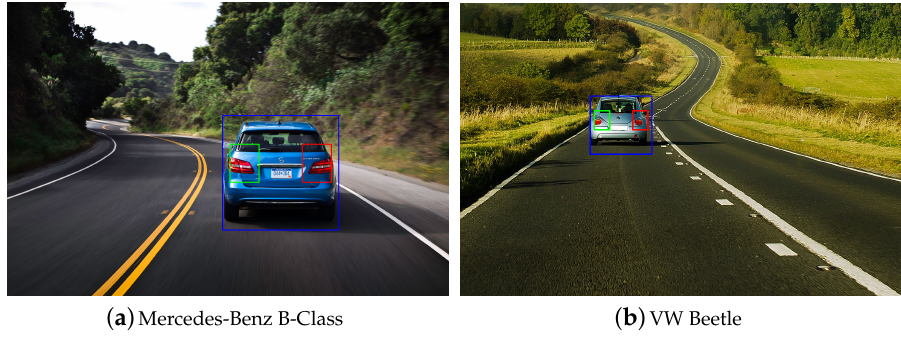
Figure 11. Taillight detection on example images of cars on a road [1].